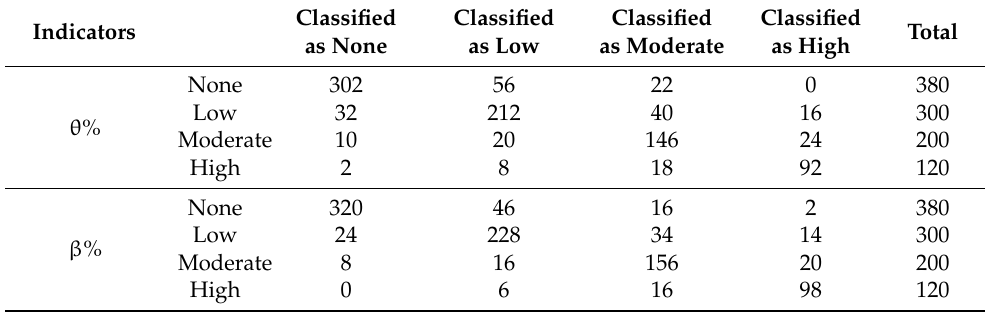
Table 5. Confusion matrix for the optimal thresholds (best cut-off points) of θ % and β